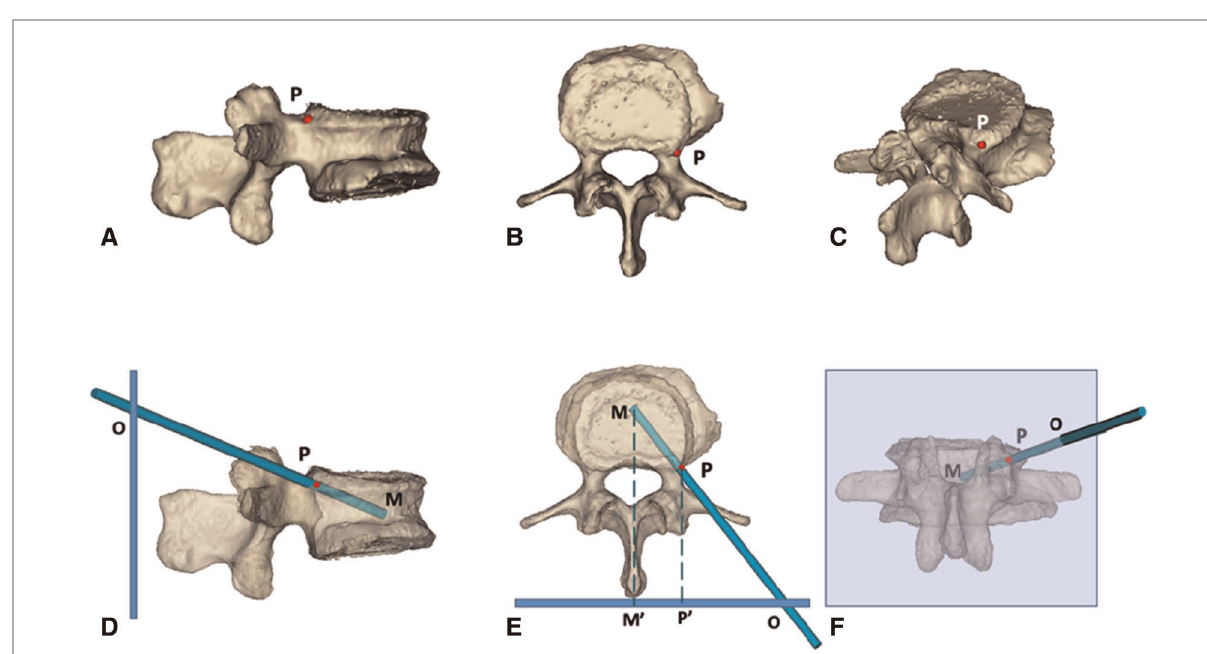
FIGURE 1 3d simulation diagram of PKP via superior pedicle notch approach. ( A – C ) the side view, top view and posterior view of the bony puncture entry point of PKP in the ideal state, respectively; the puncture needle is simulated with a long green rod, and the red P point is the bony entry point. ( D – F ) the models of the vertebral body after transparent treatment; the thick blue line in ( D,E ) and the light blue box in ( F ) represent the skin, and the green dotted line represents the vertebral body midline Point M is the fi nal puncture target point, located in the midline of the orthotropic vertebral body and the anterior middle third of the lateral vertebral body; point P is the bony entry point, located at the superior pedicle notch; point O: is the skin entry point, derived from the extension of the line connecting point M and point P intersecting with the skin. M ′ and P ′ points are the projection points of M and P points on the skin, respectively.